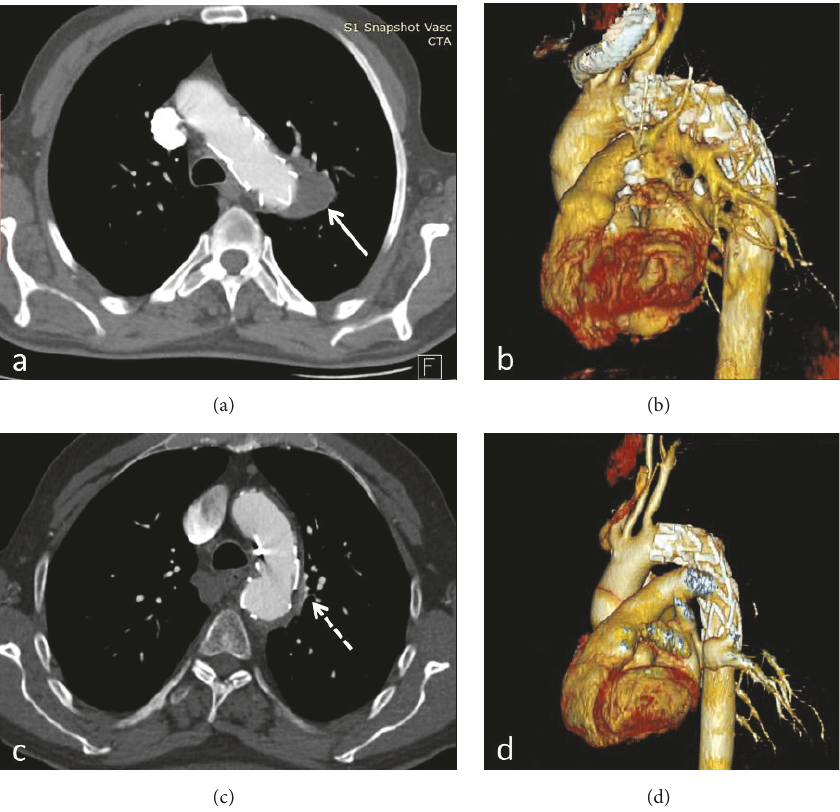
Figure 3: Case 1 (a, b). Case 2 (c, d). Contrast-enhanced CT and VRT images show complete occlusion of the aneurysm with thrombosis and shrinkage, especially in case 2 (white arrow in (a), dashed arrow in